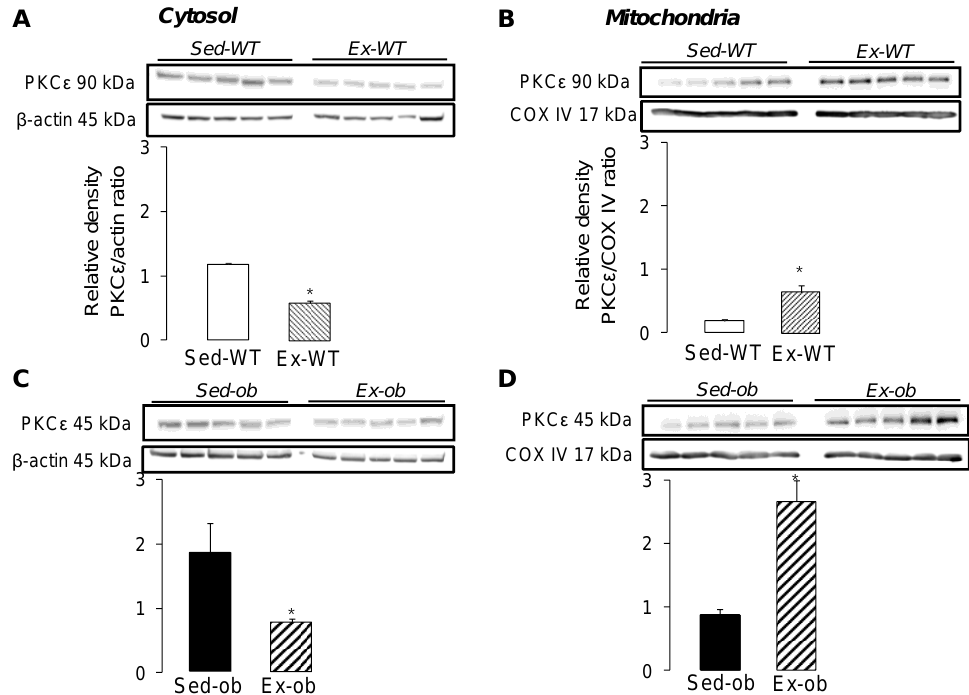
Figure 2. Western blot analysis of PKC ε in cytosol (wild-type mice, n = 5, Panel ( A ); ob/ob mice, n = 5, Panel ( C )) and in mitochondria (wild-type mice, n = 5, Panel ( B ); ob/ob mice, n = 5, Panel ( D )) in sedentary conditions (Sed) or after regular exercise (Ex). Values are expressed as mean ± SEM. * p < 0.05 vs. corresponding group.